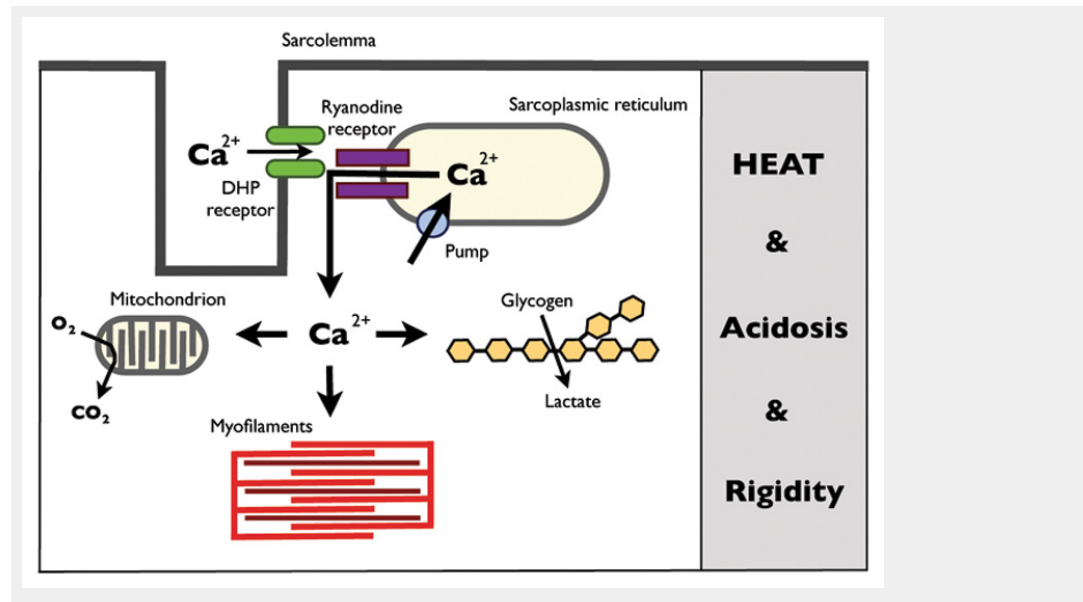
A schematic representation of the excitation-contraction coupling mechanism and the pathophysiological key elements of malignant hyperthermia (adapted from Lehmann-Horn et al. [36]). The muscle action potential is propagated along the sarcolemmal membrane into the transverse tubule, where the dihydropyridine receptors (DHP receptor) sense the action potential voltage change and open up. The conformational change of the opening DHP receptors then activates the ryanodine receptors, which release calcium from the sarcoplasmic reticulum. In malignant hyperthermia, an uncontrolled calcium release from the sarcoplasmic reticulum overwhelms the compensatory mechanisms within the skeletal muscle cell: increased muscle contractile activity and metabolic stimulation